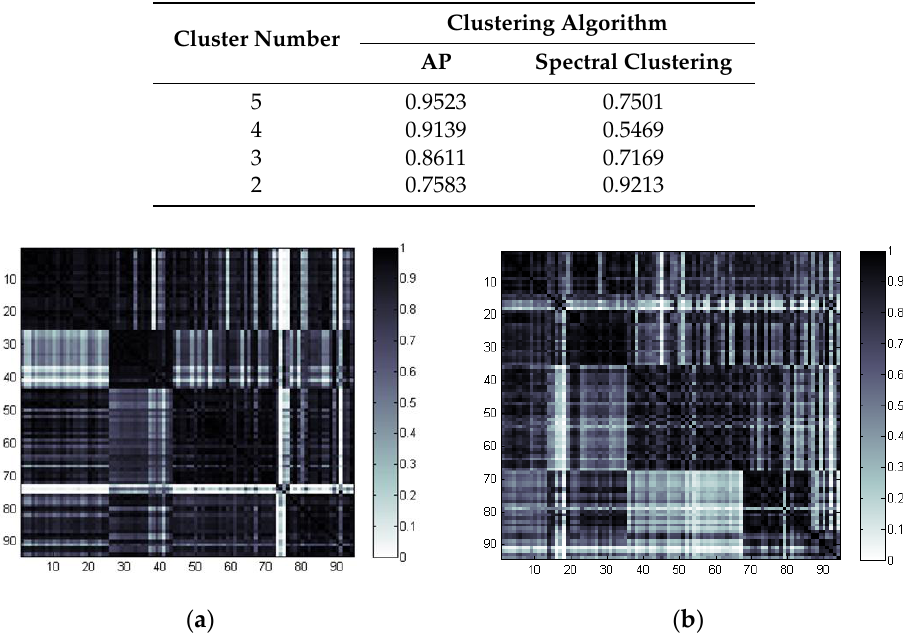
Table 2. Silhouette indexes for the discharge curves.